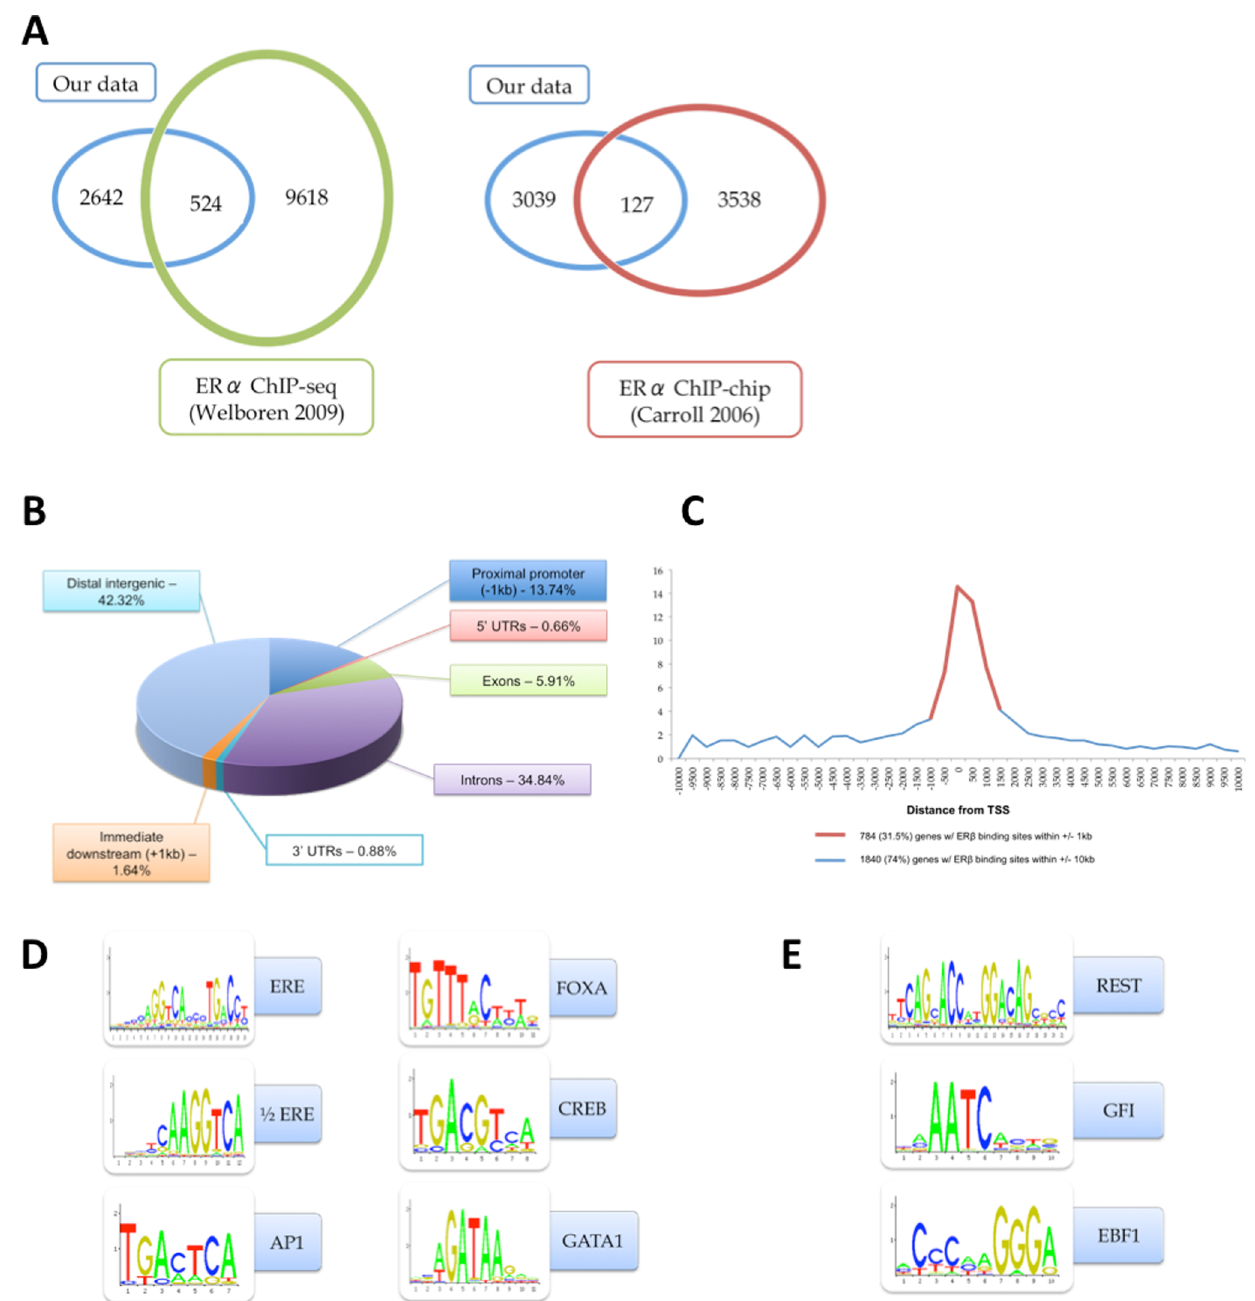
Figure 3. Overview of ER b binding regions in C4–12/Flag.ER b cells. ER b binding sites identified in C4–12/Flag.ER b cells (blue) were compared with ER a binding sites in MCF-7 cells (green and red). 524 sites are shared with the ER a landscape reported by Welboren 2009 [15]; 127 sites are shared with ER a landscape reported by Carroll 2006 [14]. (B) Global distribution of ER b : less than 15% of ER b binding sites were found in proximal promoter regions; most ER b binding sites were found in introns and distal intergenic regions. (C) Density of ER b binding sites around gene TSS. (D-E) ER b binding sites were converted to 400-base long polynucleotides, centered at the binding summit. CLOVER motif analysis [36] was used to identify enrichment of transcription factor binding motifs in this library. JASPAR transcription factor binding motif database was used as the library of known motifs; CpG island, promoter regions and chromosome 20 were used for background analysis. (D) Enrichment of motifs known to associate with ER binding sites. (E) Enrichment of motifs unique to ER b binding sites in C4–12/Flag.ER b cells. doi:10.1371/journal.pone.0071355.g003 tagged receptor was specifically immunoprecipitated with Flag M2 Mapping ER b Genomic Binding Regions in C4–12/ antibody, allowing subsequent experiments to study ER b genomic Flag.ER b functions without interference from ER a . Flag.ER b was mapped to 3166 binding sites in the C4–12/ Flag.ER b genome by ChIP-seq analysis (1% FDR) after 1 hour of